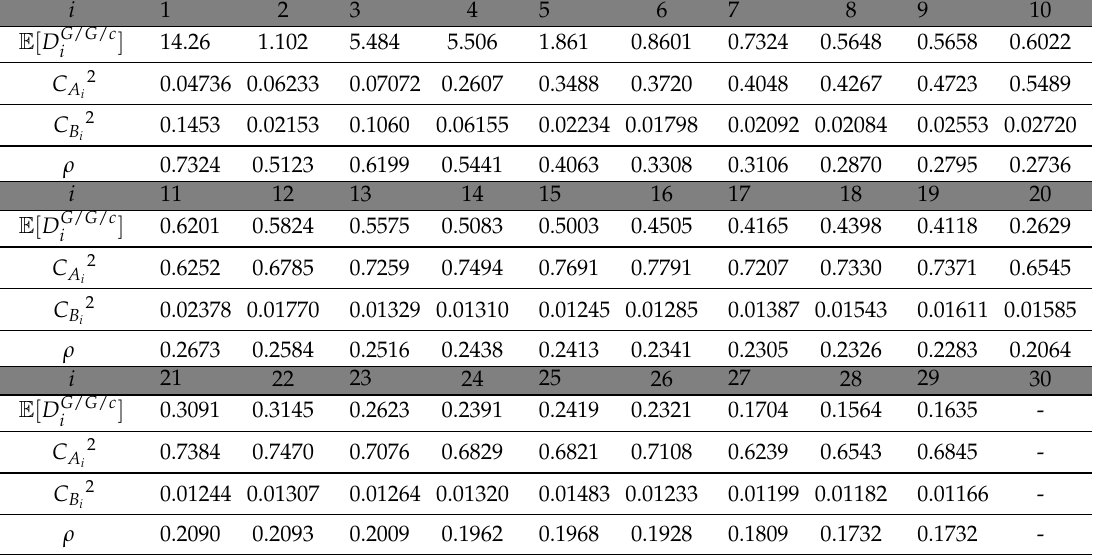
Table 6. Aircraft arrival delay and parameters of the G / G / c model, c = 3, arrival rate = 36 aircraft per